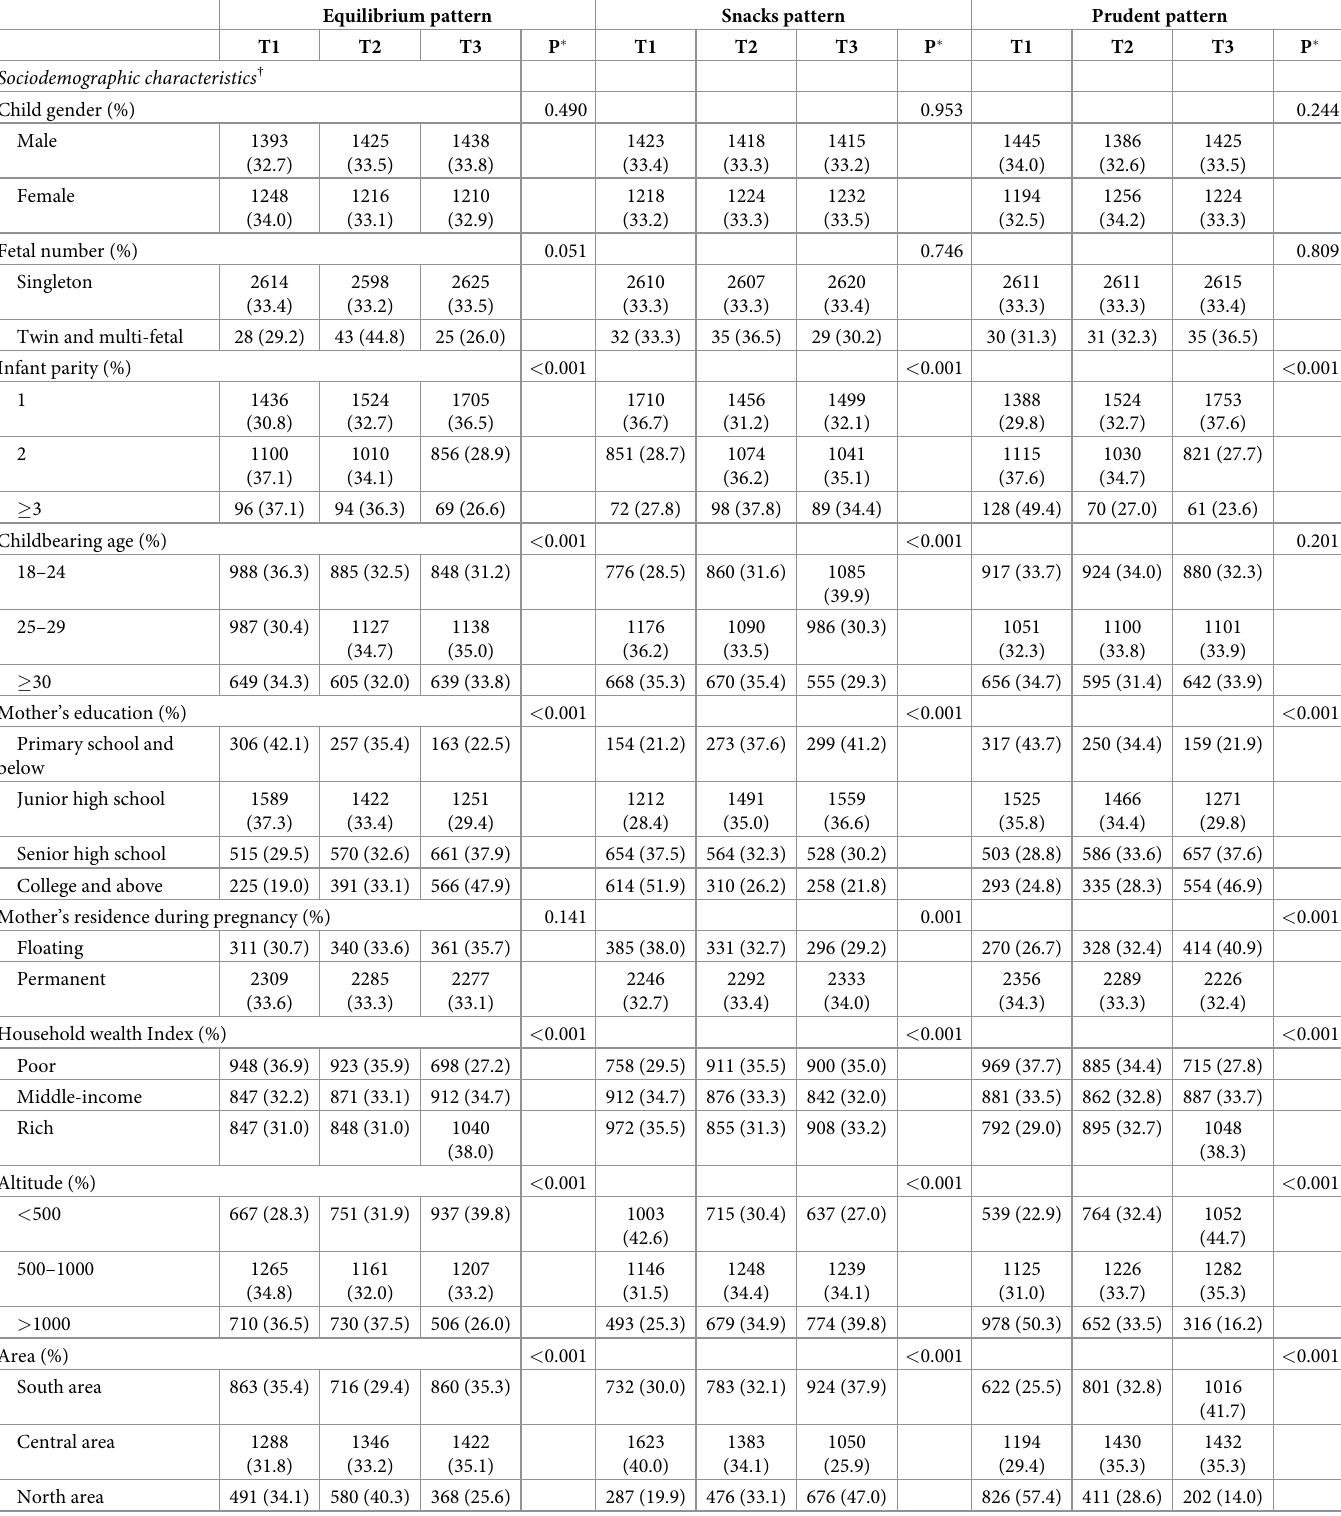
Table 2. The characteristics of dietary patterns among pregnant women (n 7934) in Shaanxi province, Northwest China, 2013. Equilibrium